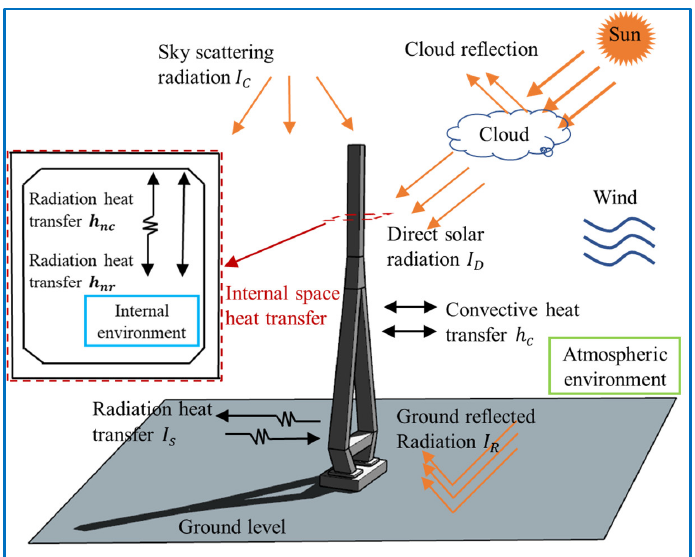
Figure 1. Schematic diagram of heat exchange between structural surfaces and the environment. Note: In the figure, I is the heat flow density and h is the heat transfer